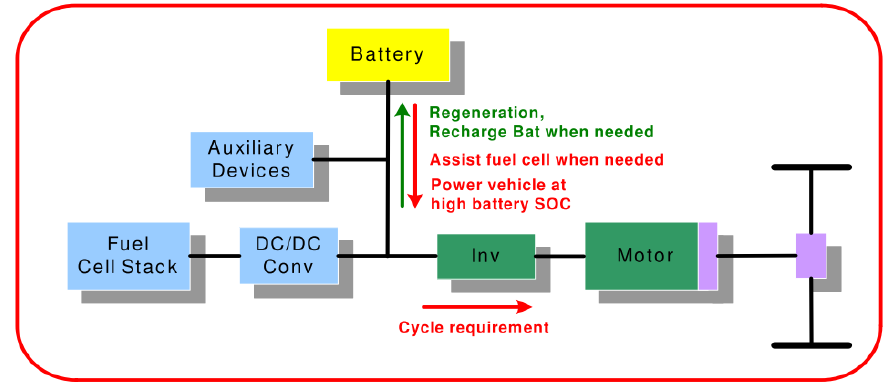
Figure 3. Basic structure of fuel cell based electric vehicle [47].